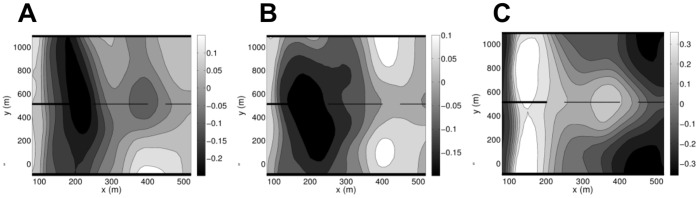
Correlation contours between the seabed and the (A) NAO, (B) the MWH and (C) the MWL, respectively.Tr. 58 (top, Northern side) and Tr. 190 (bottom, Southern side) are highlighted (solid lines). The pier is located at y = 513 m (dashed line).